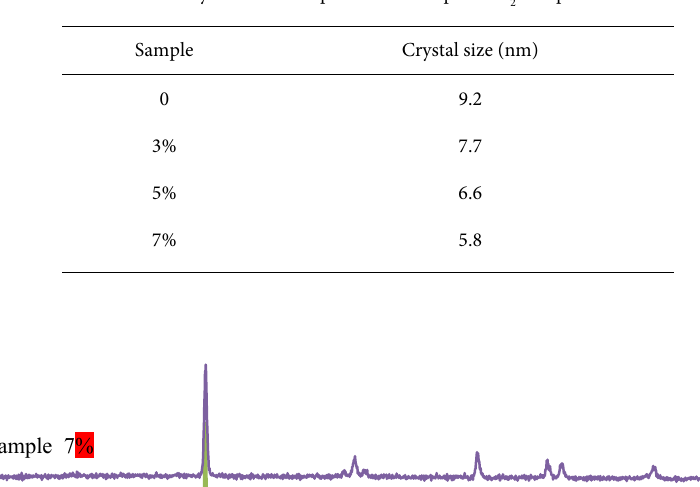
nanoparticles 2